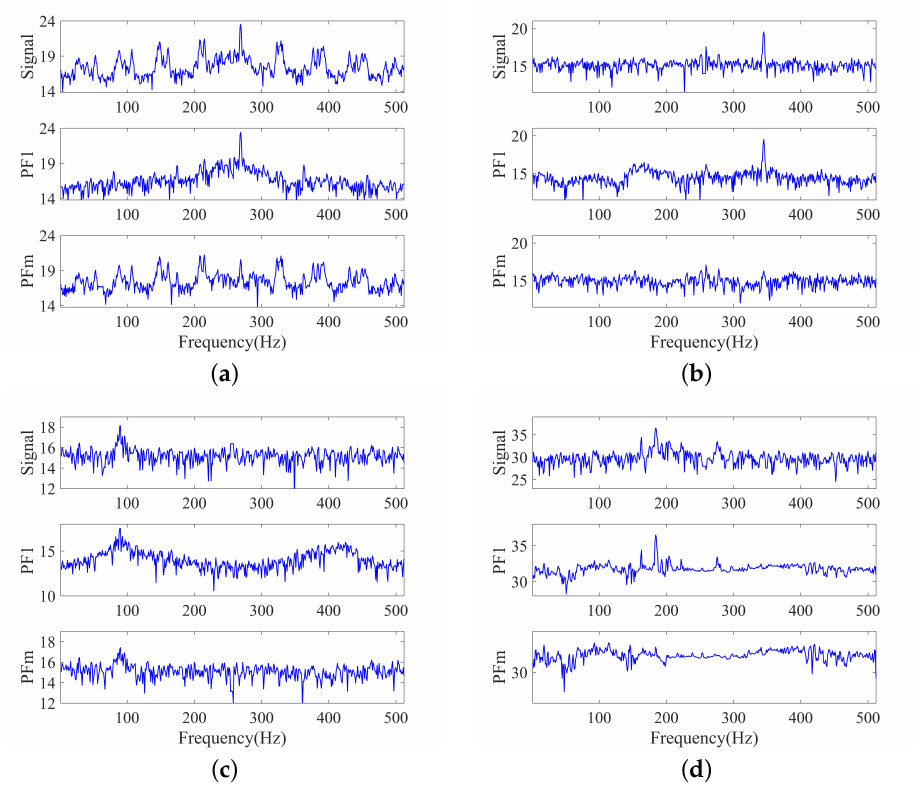
Figure 4. LMD decomposes a frame signal and then reconstructs its PF1 and PFm components. PF1 represents the main component, and PFm represents the m-DS component. ( a ) Inspire2 UAV. ( b ) MAVIC Air2 UAV. ( c ) A bird. ( d ) A group of